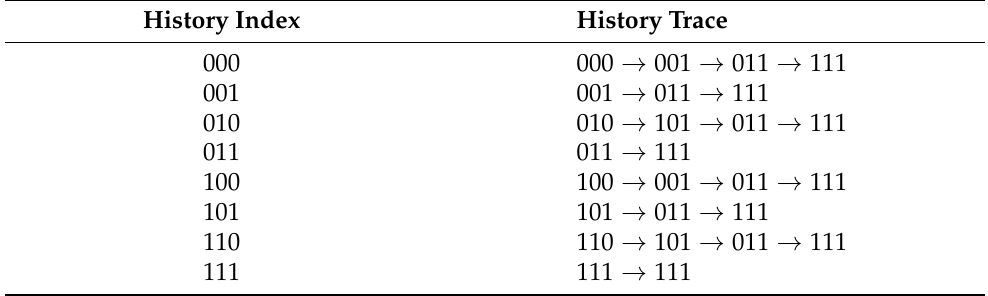
Table 6. History